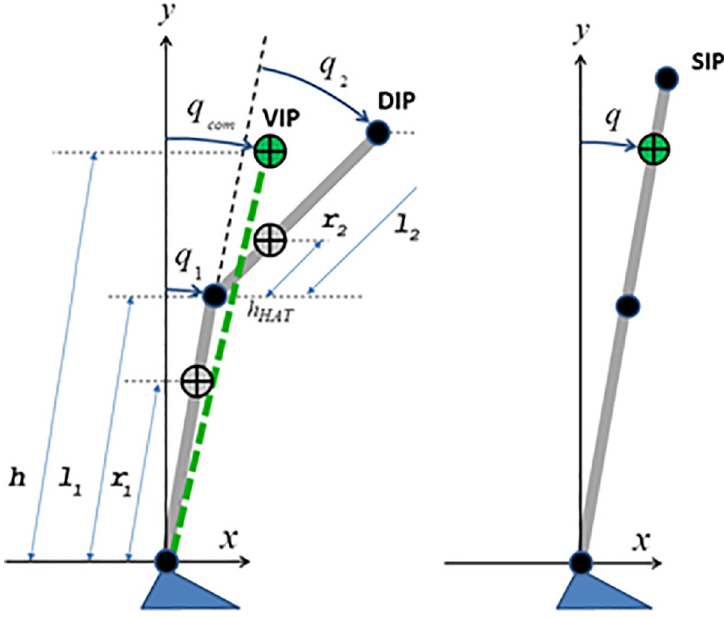
Fig 1. Biomechanical models. The DIP/VIP model (left panel) and the corresponding SIP model (right panel).